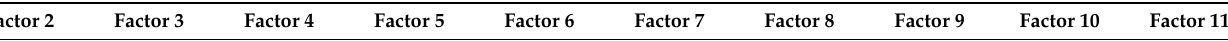
Table 3. Exploratory factor